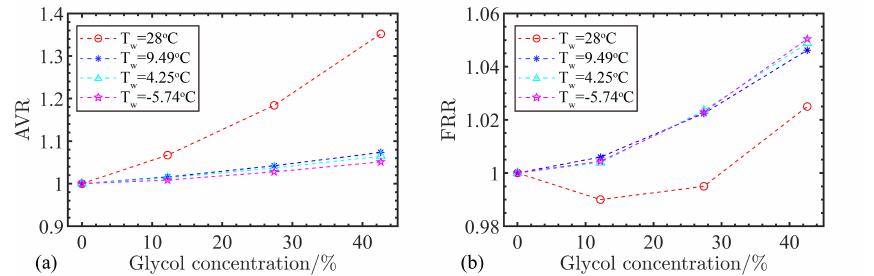
Figure 9. Plots of the AVRs and FRRs for different glycol concentrations. ( a ) Plots of AVRs. ( b ) Plots of